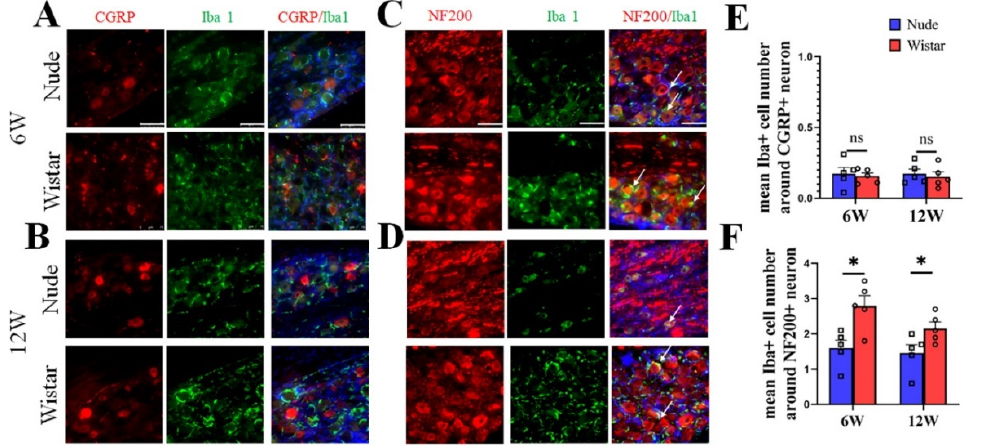
Figure 4. Immunofluorescence staining of Iba1 and CGRP/NF200 co-staining in DRG tissue. ( A , B ) Representative figures of CGRP (red) and Iba1 (green) co-staining in DRG tissue at 6 ( A ) or 12 weeks ( B ). ( C , D ) Representative figures of NF200 (red) and Iba1 (green) co-staining in DRG tissue at 6 ( C ) or 12 weeks ( D ). At 6 or 12 weeks in two groups, colocalization showed that Iba1 cells (white arrow) surround NF200+ neurons, but not CGRP+ neurons. ( E ) Quantitative analysis showed no difference in the mean number of Iba1+ cells around CGRP+ neurons in the DRG between the two groups. ( F ) Quantitative analysis showed the mean number of Iba1+ cells around NF200+ neurons in DRG of Wistar rats was higher than in nude rats both at 6 and 12 weeks. Scale bar 50 µ m. Student’s t -test in ( E ) and ( F ). Sample size (n): n = 5. * p < 0.05; nude rats vs. Wistar rats.